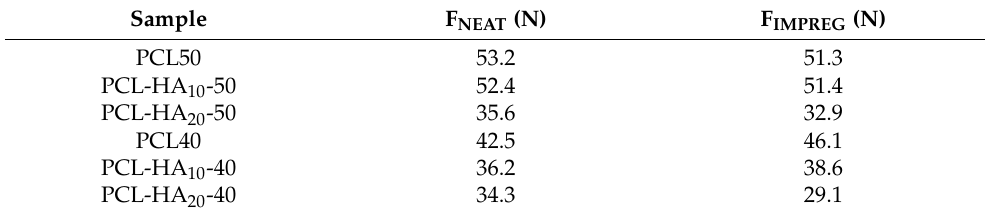
Table A2. The compression force to start deformation of neat (F NEAT ) and impregnated (F IMPREG )